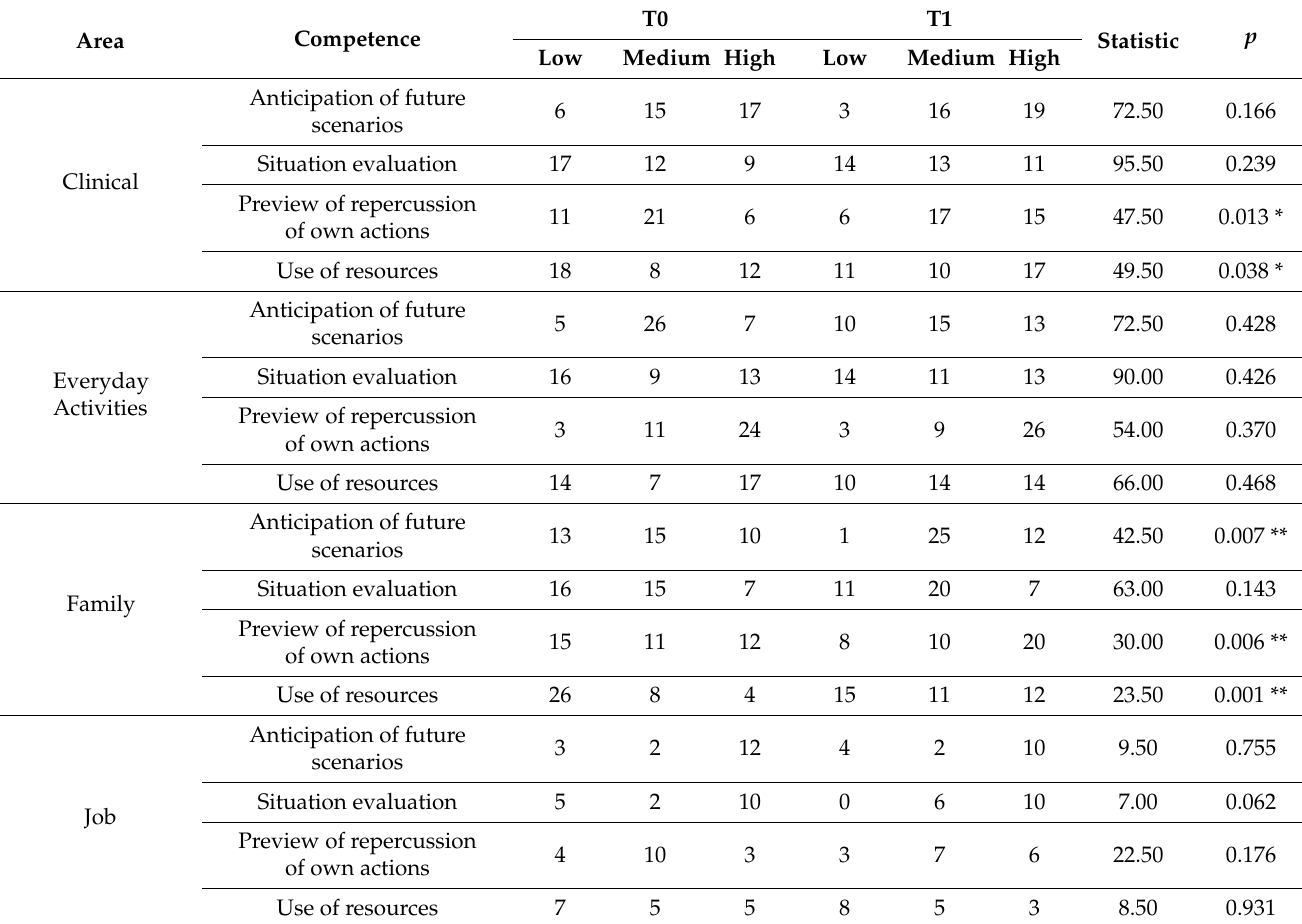
Table 5. Comparison of level of competence for each content